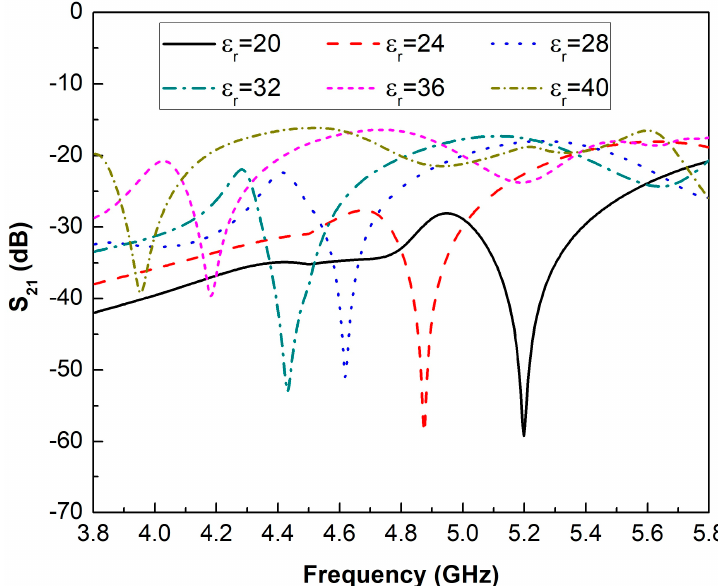
Figure 2. Simulated results of the transmission response (S 21 ) when the dielectric permittivity is changed from 20 to 40.